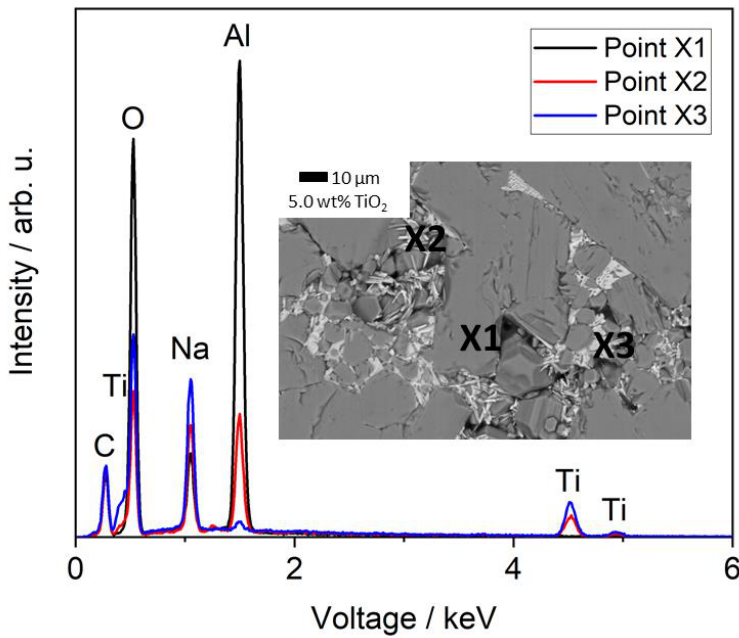
Figure 10. EDX point analysis of a Na- β″ -alumina sample doped with 5.0 wt% TiO 2 (sintered at